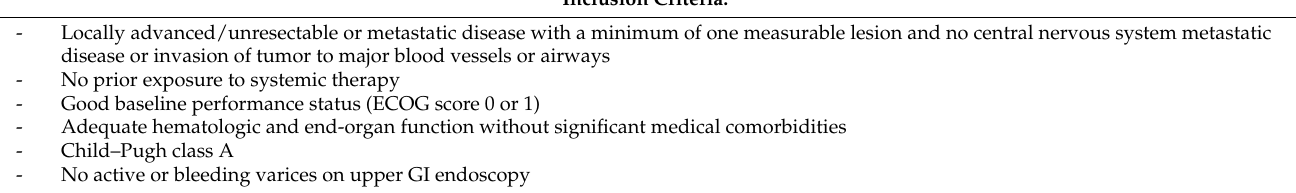
Table 2. Key inclusion and exclusion criteria of IMbrave 150 trial in patients with hepatocell- ular